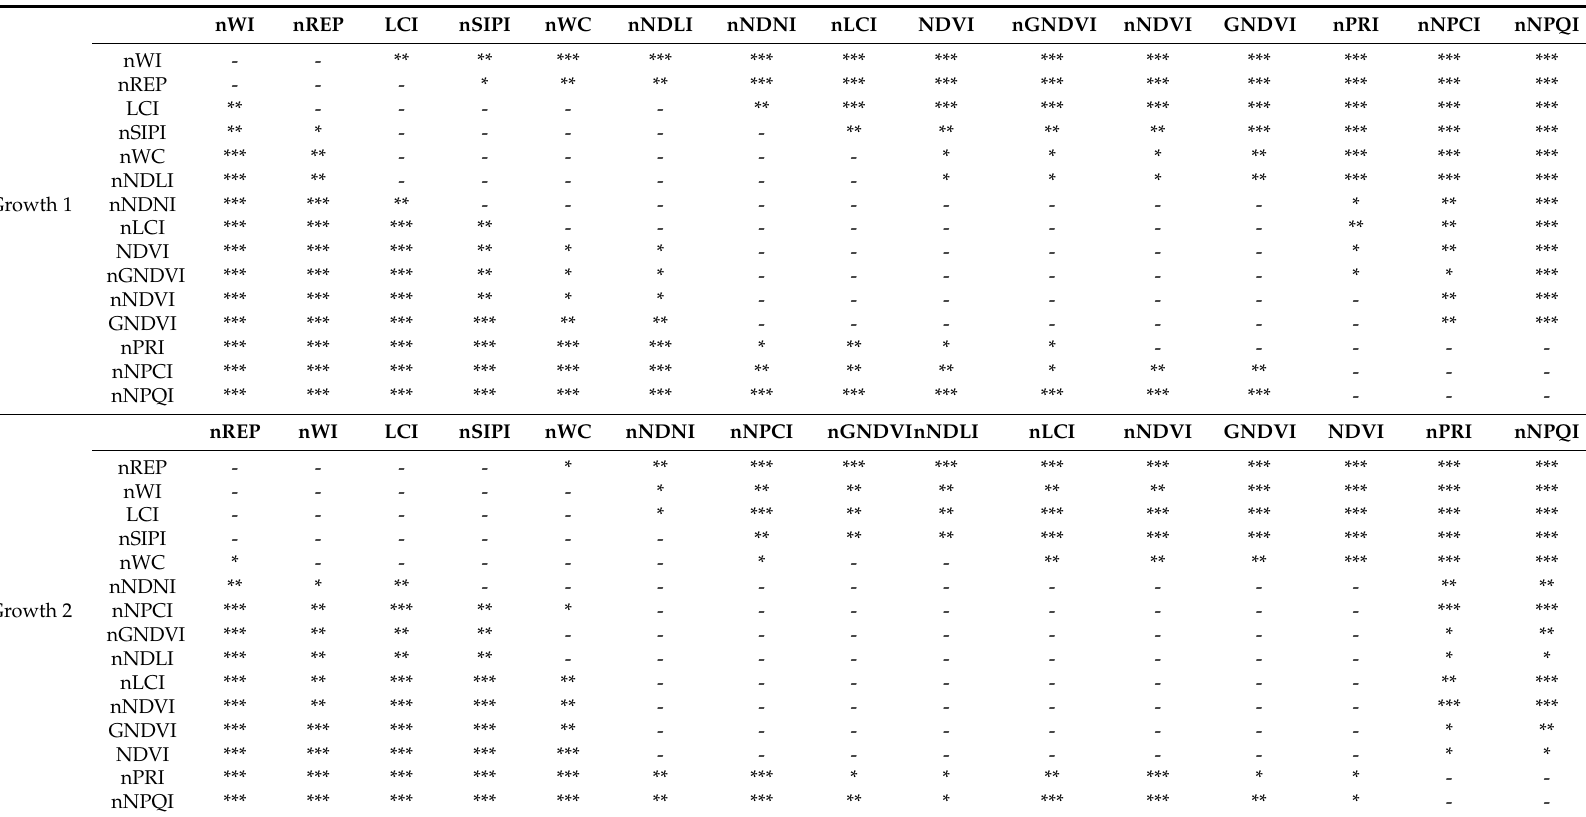
Table A1. Performance of the fifteen VIs for distinguishing the five grassland communities in Growth 1 and Growth 2 (Welch test with α = 0.9; * p < 0.1; ** p < 0.05; *** p < 0.01, n =